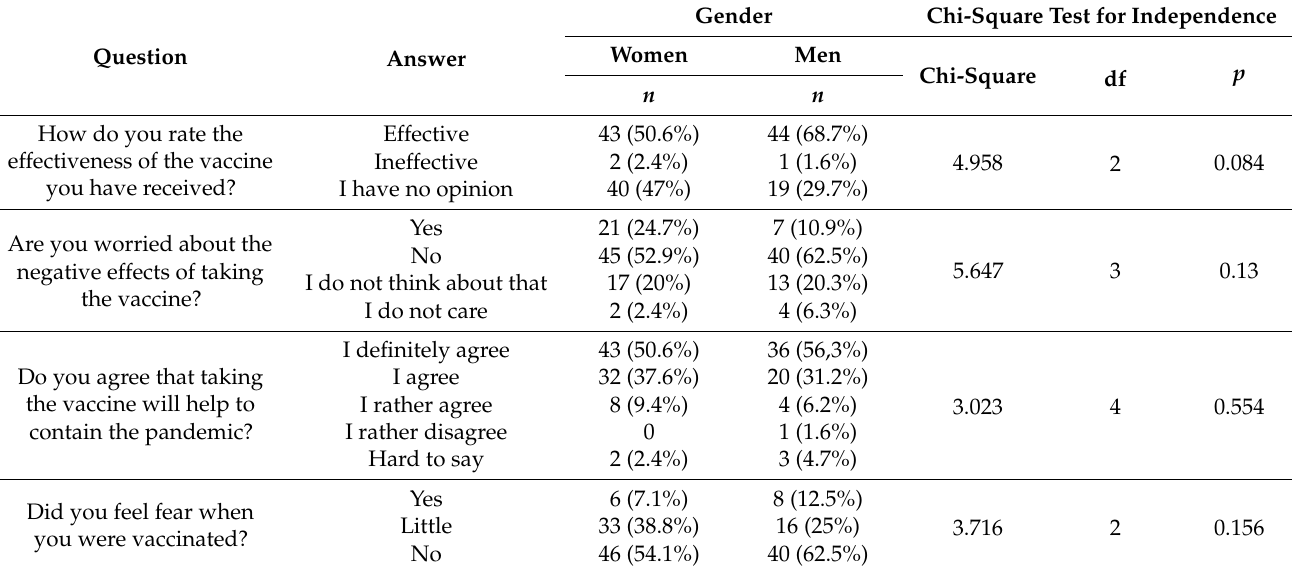
Table 3. Comparison of the answer of the given question with